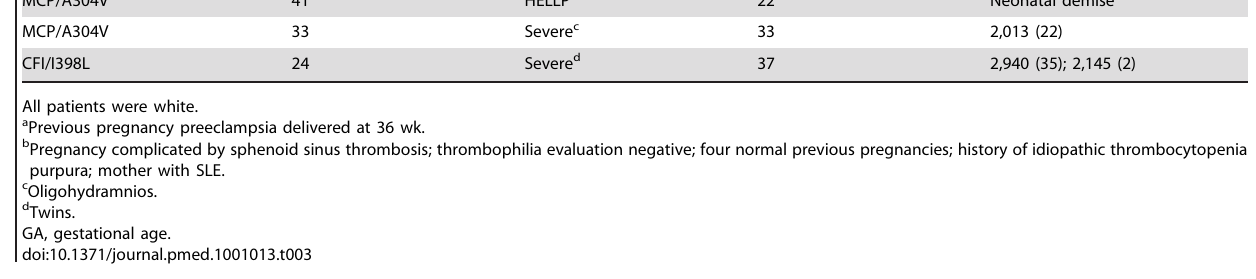
Mutation/Variant Maternal Age